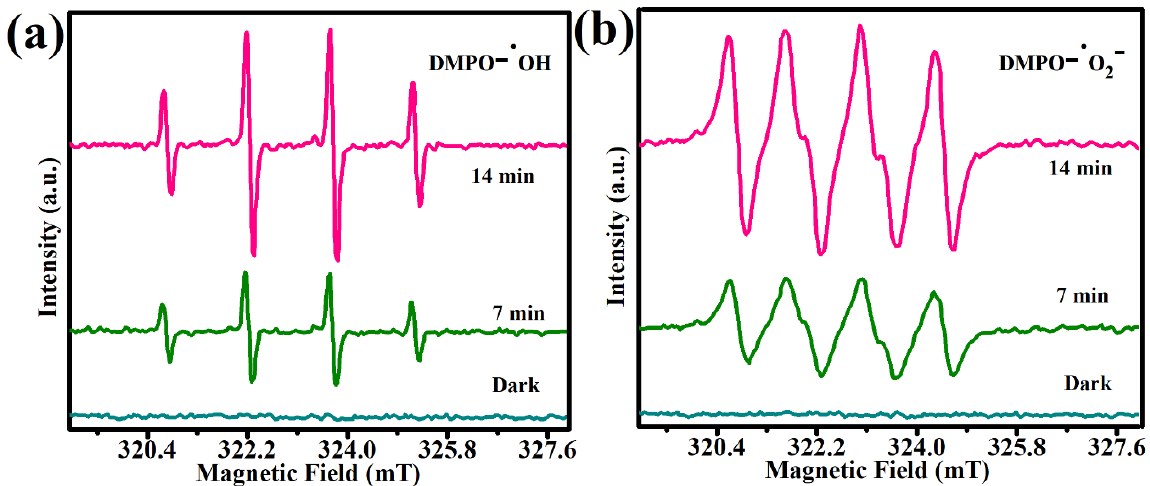
Figure 9. 70%SGCN/1%Te@NiS NCs ESR spectra. For DMPO − • OH ( a ), this was performed in an aqueous suspension, and for DMPO − • O 2 − ( b ) this was performed in a methanol suspension.